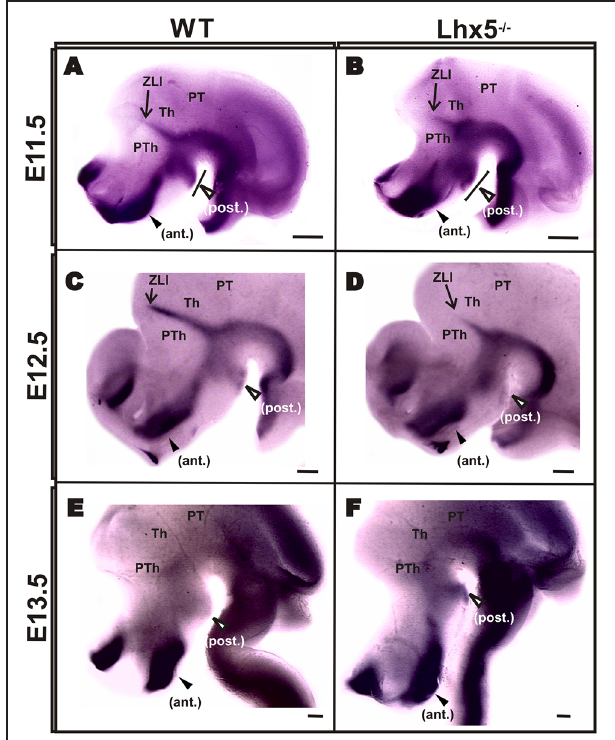
FIGURE 4 | Shh expression in Lhx5 mutants. Comparison of Shh expression on whole-mount ISH in control and mutant embryos at E11.5 (A,B) , E12.5 (C,D) and E13.5 (E,F) . Note that the posterior expression domain (empty arrowheads) is present at all stages analyzed (A–F) but appears expanded anteriorly in the mutant at E11.5 (brackets in A,B ). (A–D) The ZLI is present at E11.5 and E12.5, but its dorsal extent (indicated with arrows) is shorter in Lhx5 mutants at E12.5. (A–F) . Anterior is to the left. Abbreviations: ant., anterior; Th, thalamus; PT, pretectum; PTh, prethalamus; post., posterior; ZLI, zona limitans intrathalamica. Scale bars: (A,B) 200 µ m, (C-F) 400 µ m.